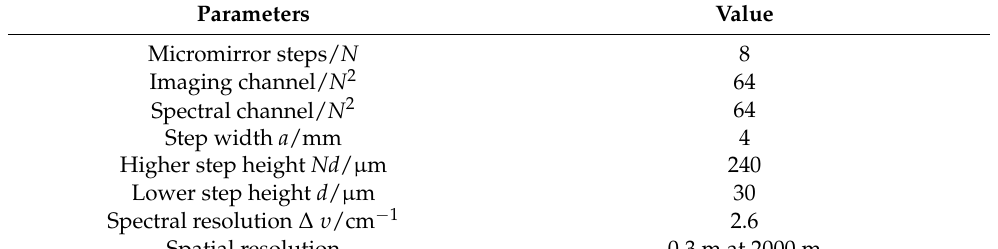
Table 1. Main SIIFTS parameters.